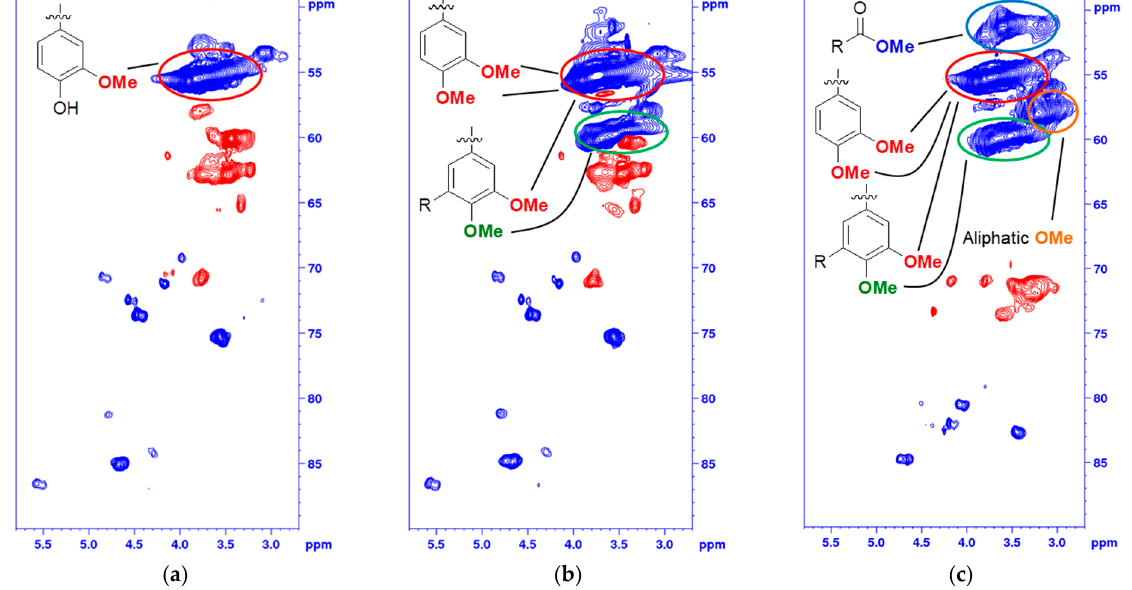
Figure 3. Multiplicity edited HSQC of the oxygenated aliphatic area of ( a ) Pine BLN lignin; ( b ) selectively methylated Pine BLN lignin and ( c ) fully methylated Pine BLN lignin. (CH/CH 3 shown as positive (blue) and CH 2 as negative (red).